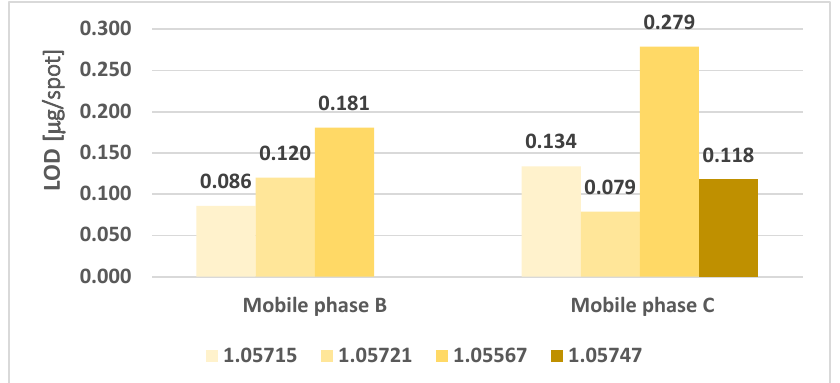
Figure 6. Mean values of the limit of detection of sertraline, obtained by adsorption thin-layer chromatography, where the mobile phases were as follows: B—chloroform + methanol + glacial acetic acid, 5:4:1 ( v/v/v ); C—acetone + toluene + ammonia, 10:9:1 ( v/v/v ). The chromatographic plates were: